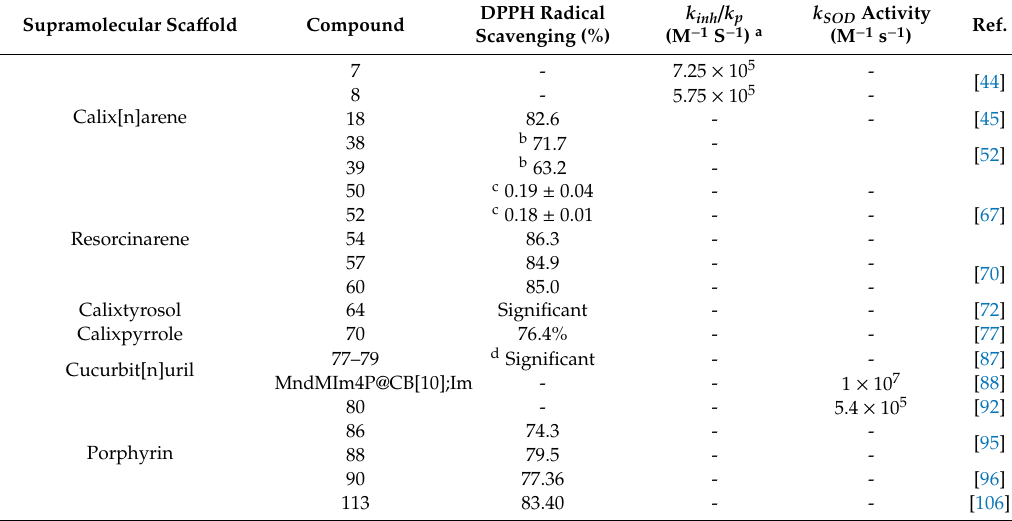
Table 1. Antioxidant activity of selected derivatives of calix[n]arene, resorcinarene, calixtyrosol, calixpyrrole, cucurbit[n]uril, and